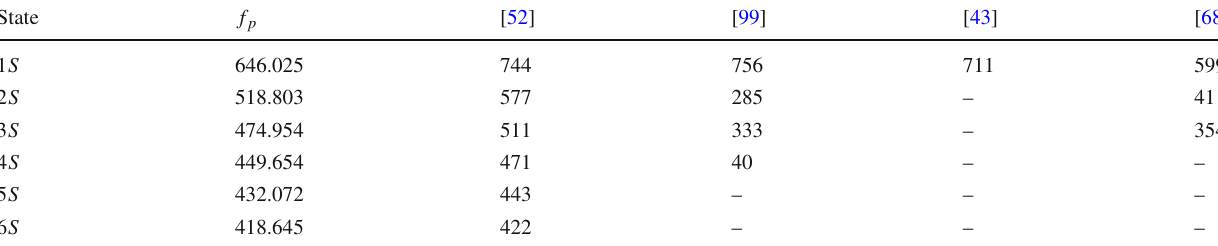
Table 10 Pseudoscalar decay constant of bottomonia (in MeV)